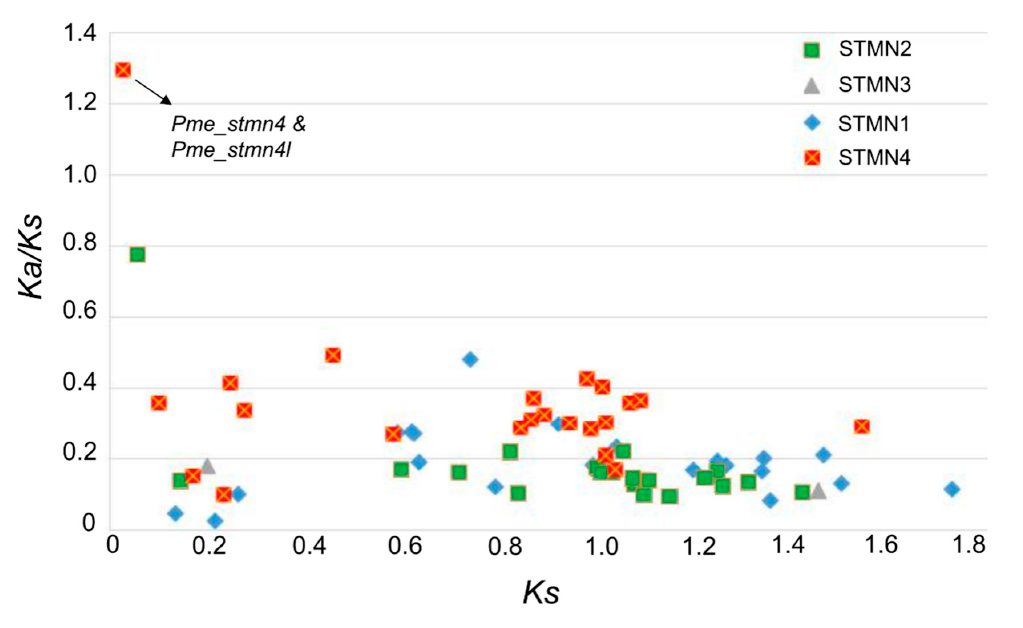
Figure 4. Relative rate of divergence for duplicated stathmin genes.